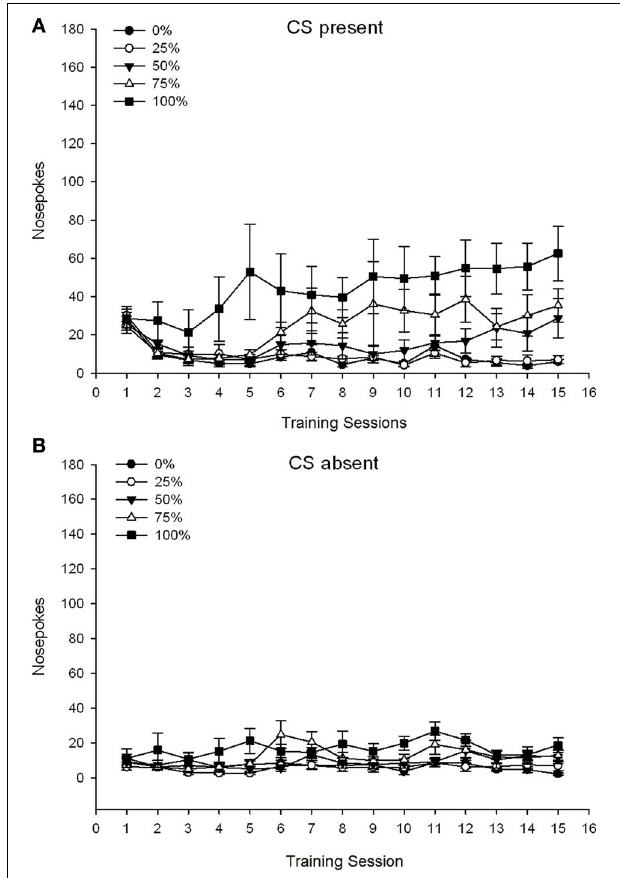
FIGURE 7 | Mean (SE) approach responses (nose pokes) on 15 sucrose training sessions in groups of Lewis rats ( n = 8/group) exposed to sucrose reward (10% solution) delivered under 0, 25, 50, 75, or 100% variable schedules. The conditioned stimulus was a light (120s). Group 0 received the same number of rewards as group 100 in the absence of conditioned stimuli. (A) Scores when CS was present (5s × 20 trials). (B) Scores when CS was absent (average for 5 × 20s while light was off).